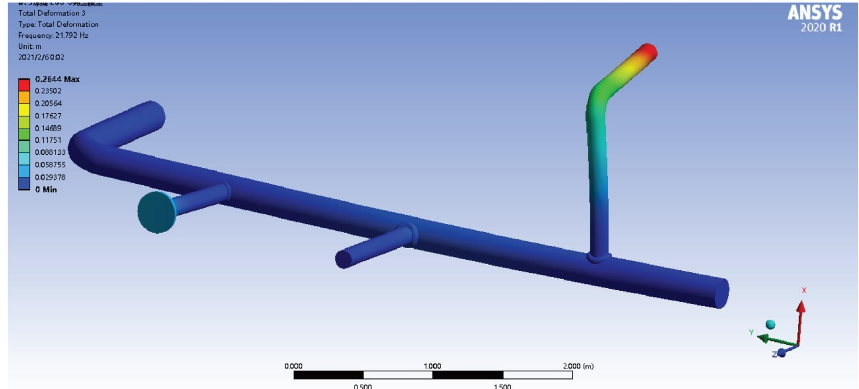
Figure 14: Tird modal shape of model